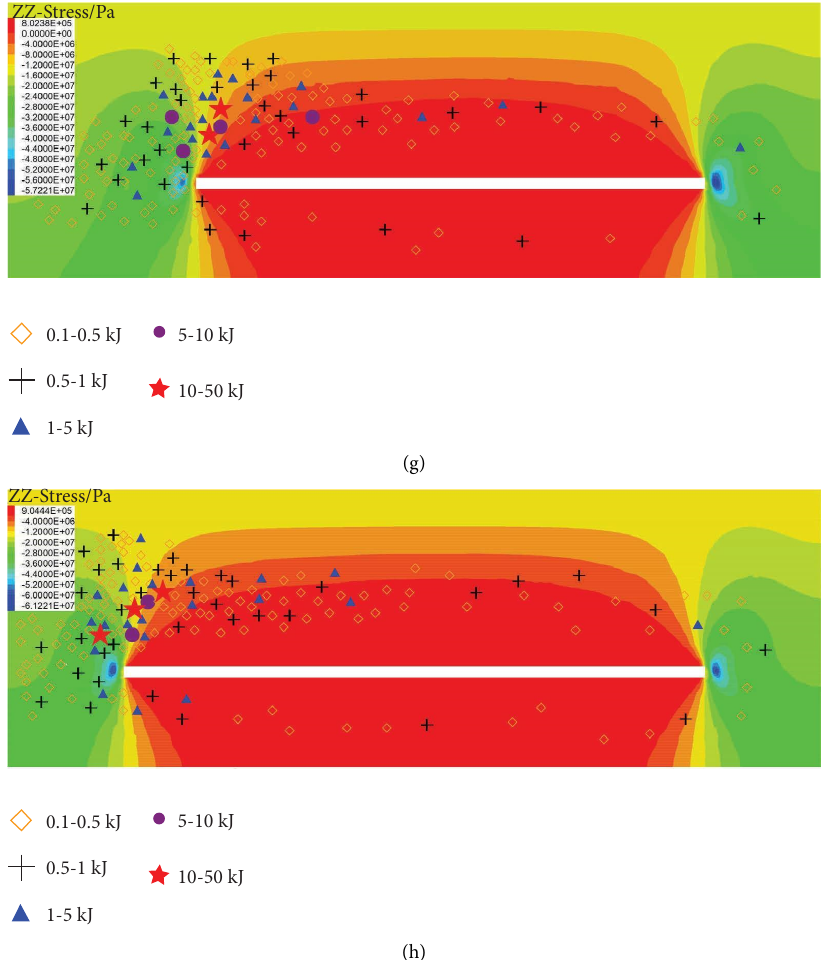
Figure 4: Distribution of microseismic events on vertical stress cloud. (a) Caving 50m. (b) Caving 100m. (c) Caving 150m. (d) Caving 200m. (e) Caving 250m. (f) Caving 300m. (g) Caving 350m. (h) Caving